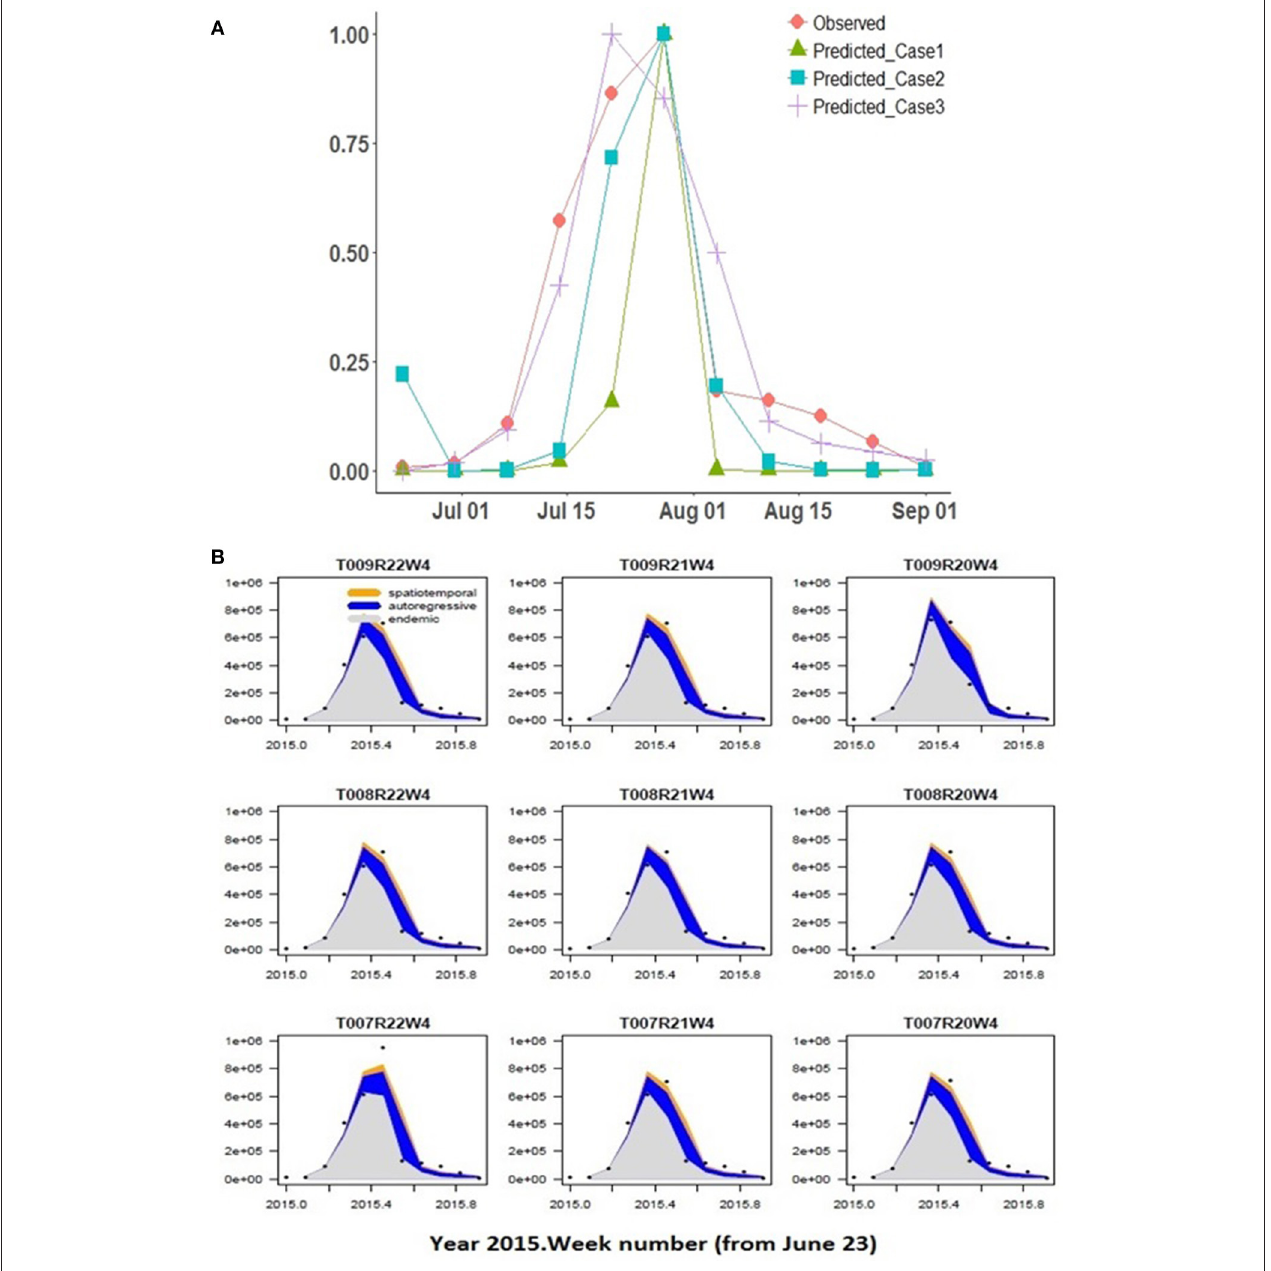
FIGURE 6 | (A) Spatial model predictions of the hhh4 model for cases 1–3 with different climate input data are shown compared to observed at the Lethbridge collection site, (B) Predicted Pst disease incidence (scaled 0–1) within the Lethbridge township (TW008R21W4) and its neighboring townships for the best-fitting model (case 3) vs. number of weeks. Variability in the endemic, autoregressive, and spatio-temporal contributions are shown driven by climate variability across the